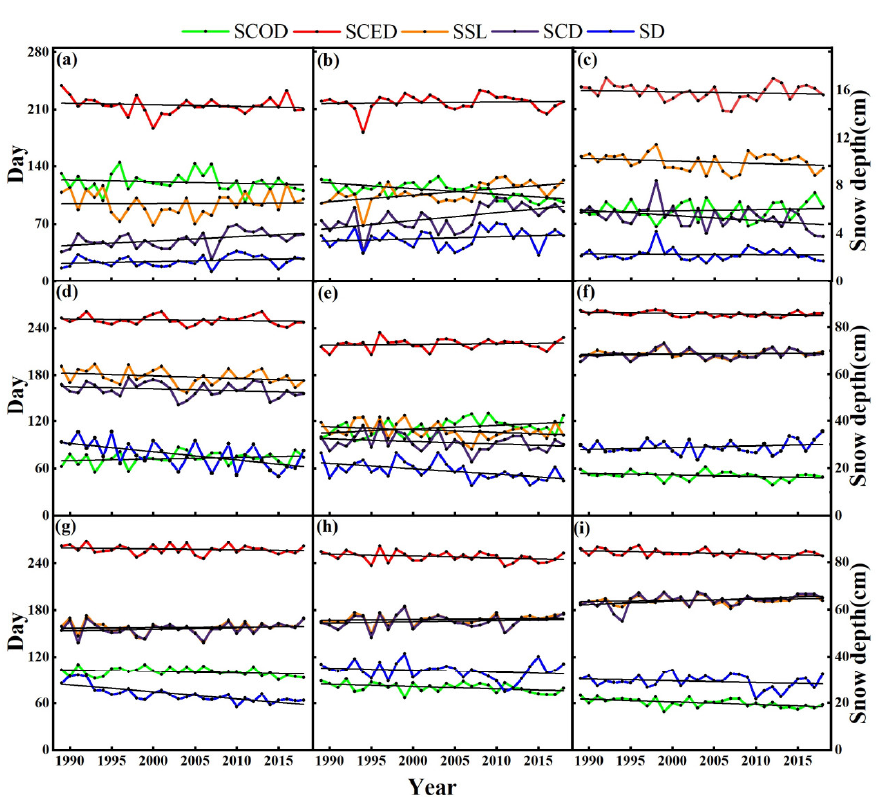
Figure 9. Interannual variations in SD and SP in ( a ) the Alps, ( b ) the Rocky Mountains, ( c ) the Qinghai–Tibet Plateau, ( d ) Alaska, ( e ) the Eastern European Plain, ( f ) the Eastern Siberian Mountains, ( g ) Northern Canada, ( h ) the West Siberian Plain, and ( i ) the Central Siberian Plateau. The vertical axes corresponding to SCOD and SCED indicate the day in the snow hydrological year, while the vertical axes corresponding to the SSL and SCD indicate the number of days accumulated during the snow hydrological year.